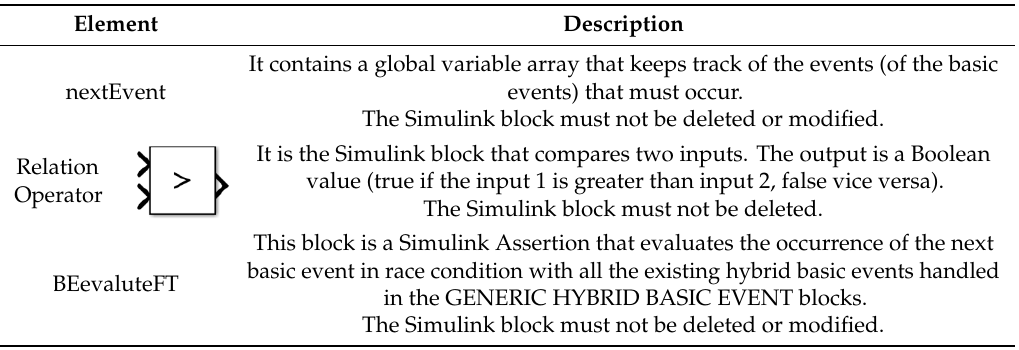
Table A2. Marking of the components of the RACE CONDITION Simulink block.